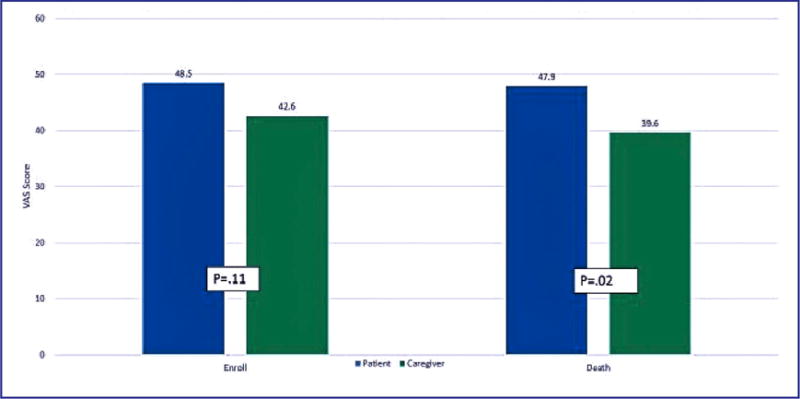
Preference Scores: Paired T-testsVAS: QOL Exclusively=0, Survival Exclusively=100